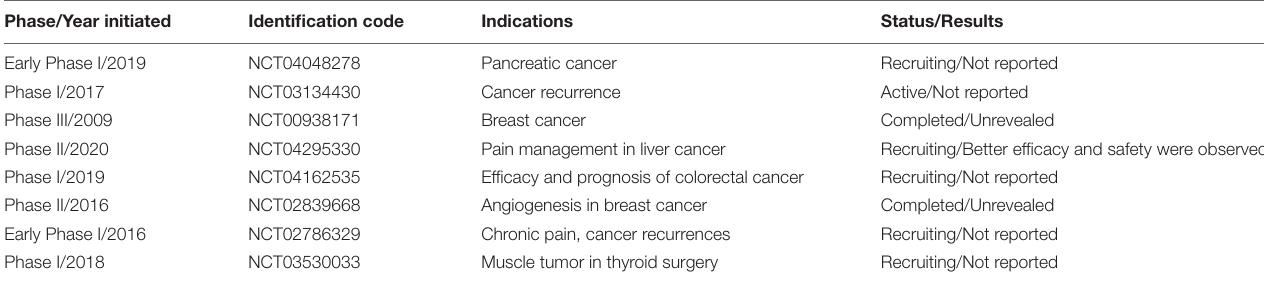
TABLE 2 | Several clinical trials using lidocaine in cancer treatment a